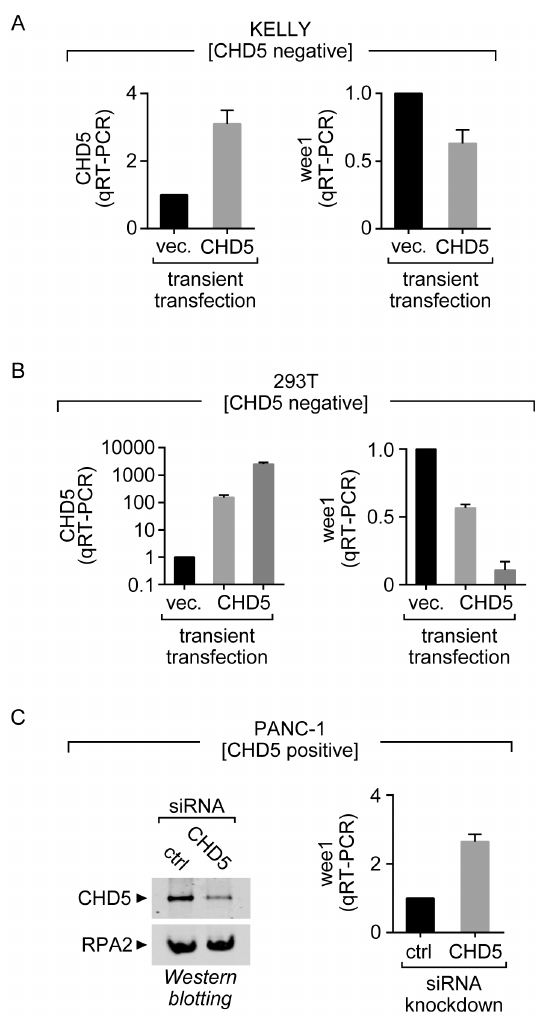
Figure 2. CHD5 expression leads to repression of WEE1 . (A) The neuroblastoma line KELLY or (B) 293T-derived cells were transiently transfected with vector (vec.) or the vector containing the human CHD5 cDNA. In the case of the 293T-derived cells, two amounts of CHD5 cDNA were transfected (see Methods). Two days after transfection, the cells were harvested and total RNA was prepared. Quantitative RT-PCR was performed to monitor the levels of the CHD5 and WEE1 transcripts. The values shown are normalized to a 5S rRNA housekeeping transcript. (C) CHD5 levels were reduced siRNA-mediated knockdown in PANC-1 cells. As a control (ctrl), a scramble siRNA was transfected in parallel. The levels of CHD5 protein were detected by western blotting (left) and the levels of WEE1 mRNA were analyzed by qRT-PCR. Error bars represent SD [n=3].